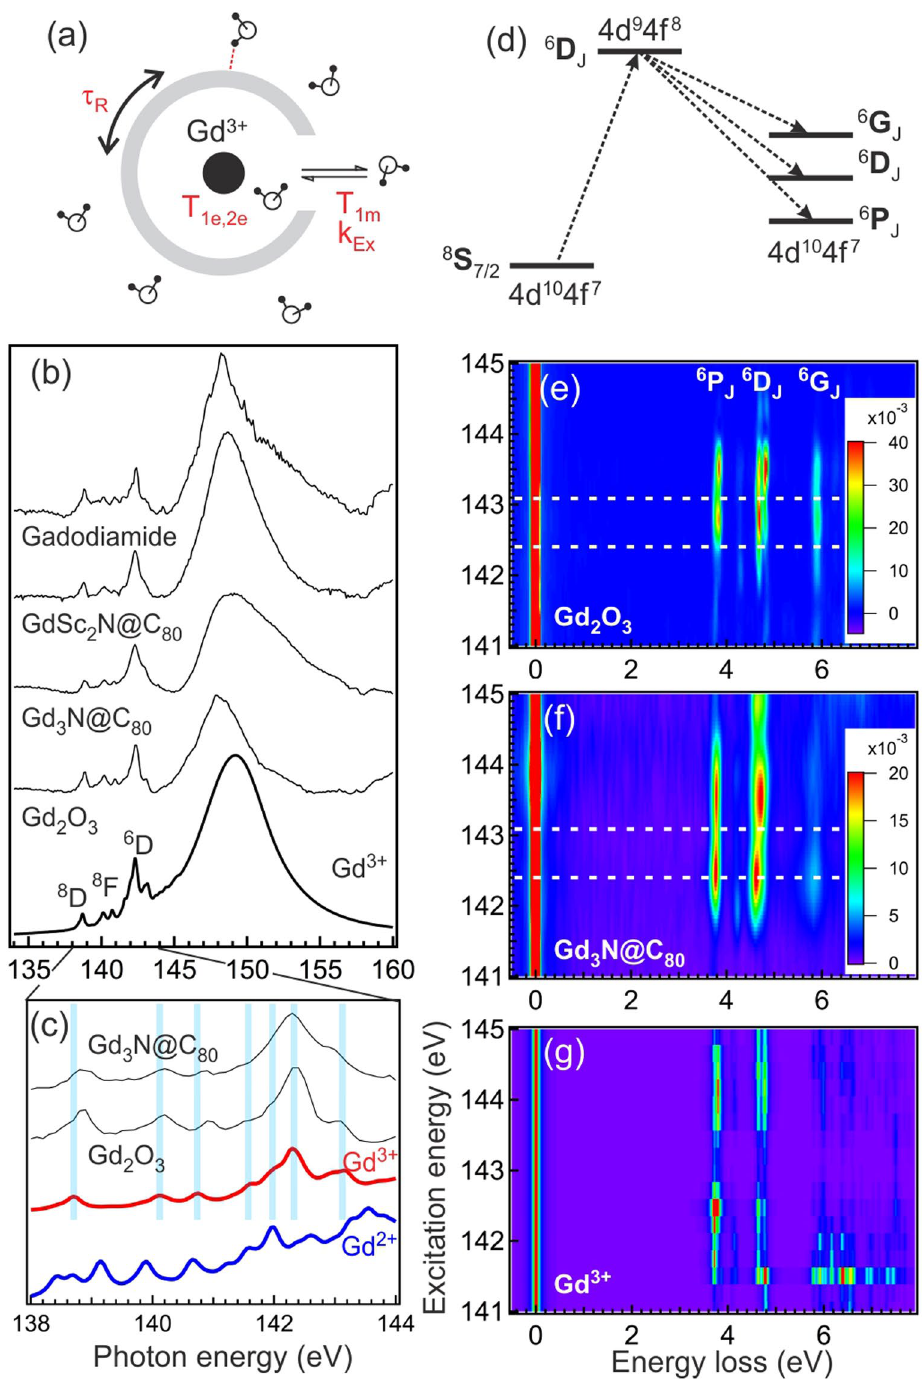
Figure 1. ( a ) Schematic illustration showing some key parameters affecting the MRI relaxivities: the electronic spin relaxation time of metal ions T 1 e ,2 e , the rotational correlation time τ R and inner sphere water exchange reaction T 1 m + k ex . ( b ) From top to bottom: experimental XAS spectra (thin lines) of Gadodiamide, Gd 1 Sc 2 N@ C 80 , Gd 3 N@C 80 , and Gd 2 O 3 compared with simulated XAS spectrum using single Gd 3 + ion (thick line). Simulation parameters are listed in Table 1 (baseline). ( c ) Zoom-in pre-edge region of XAS spectra. The simulated spectra with Gd 3 + and Gd 2 + ion are denoted by thick red and blue lines, respectively. The blue vertical lines mark the main peak positions and are guides for eyes. ( d ) Schematic illustration of RIXS process producing the inelastic features with term symbols 6 P J , 6 D J , and 6 G J (in [3.5 eV, 8 eV] energy loss window). ( e – g ) RIXS maps of ( e ) Gd 2 O 3 , ( f ) Gd 3 N@C 80 , and ( g ) simulated Gd 3 + single ion. The experimental RIXS maps in panels (e) and (f) are produced by interpolating the RIXS spectra recorded at 141, 141.5, 142, 142.4, 142.7, 143.1, 143.5, 144.5, and 145.5 eV excitation photon energies. The intensity of elastic peak (zero energy loss) is scaled to 1 with color bars shown on the right. White dashed lines in panels (e) and (f) denote the excitation photon energies used in Figs 2 and